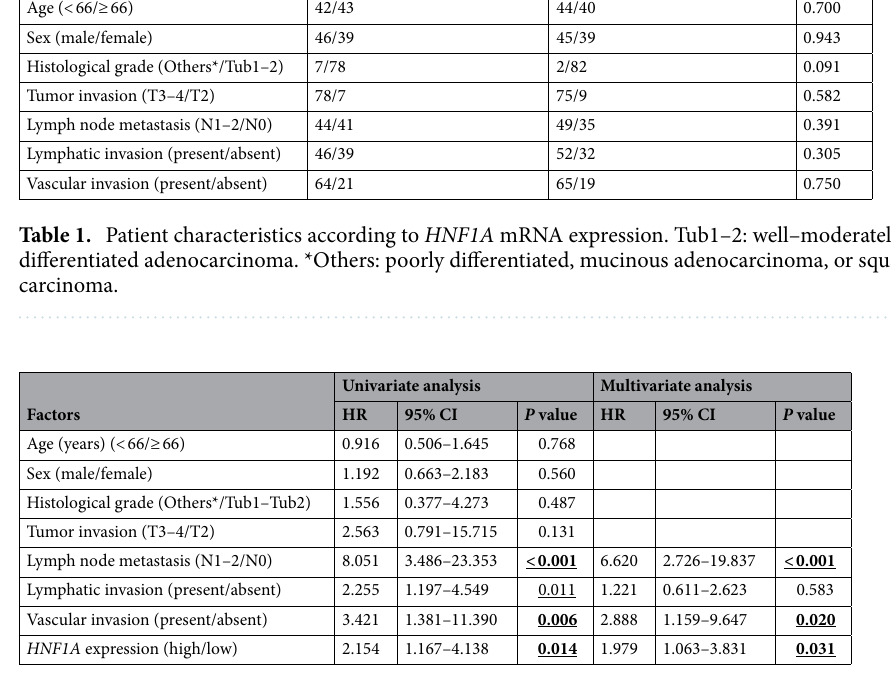
Table 2. Univariate and multivariate analyses of disease-free survival based on HNF1A expression and clinicopathological variables. *Others: poorly differentiated, mucinous adenocarcinoma, or squamous cell carcinoma. The significance for the boldunderline indicate independent risk from multivariate analysis. The significance for the underline indicate significant risk from univaliate analysis.